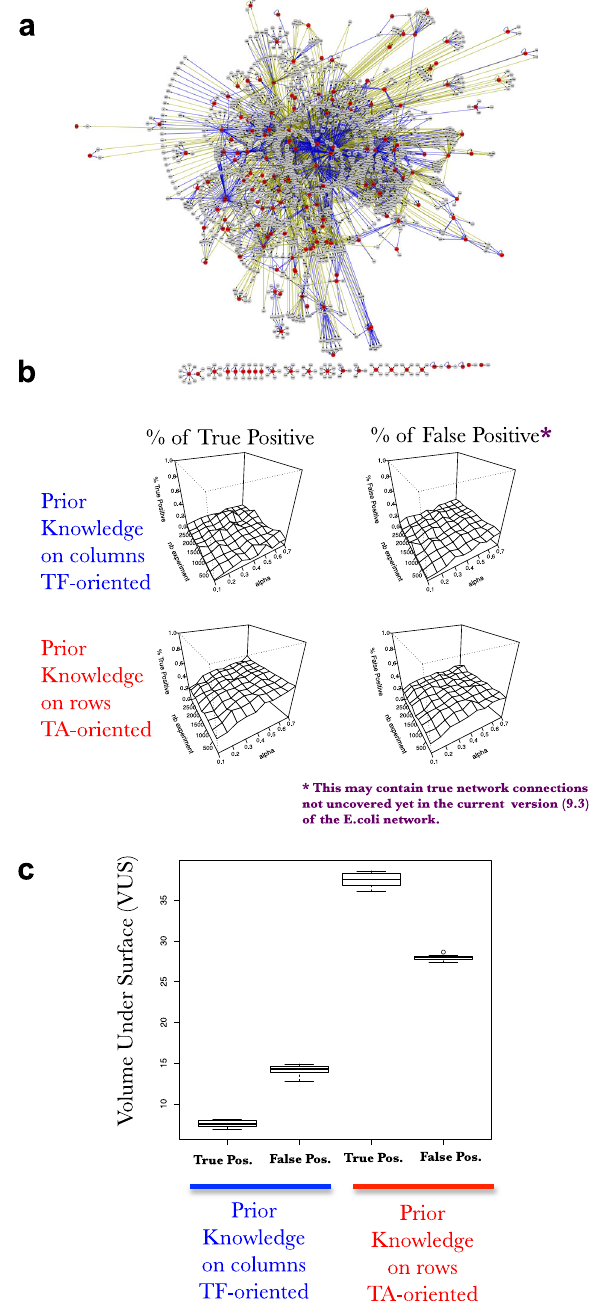
Fig. 5 TA-oriented prior knowledge is superior to TF-oriented prior in order to supervise SVM machine learning on real data. a Cytoscape display of the current E. coli network (version 9.3 retrieved from http://regulondb.ccg.unam.mx/) b Surfaces exploring the SVM accuracy (% of true positive on left and % false positive in right ) to predict the connections in E. coli network (171 TF, 1493 TA) using an increasing number of real gene expressions ( nb experiment ; y -axis) and an increasing fraction of the network as prior knowledge ( alpha ; x -axis). Percentage of true positive and false positive are evaluated based on predictions of the presence of an edge and its positive or negative in fl uence. c Bootstrap results for ten learning processes as the one described in b . For each bootstrap cycle 90% of the network has been resampled and genes expression randomized. The panel represents the boxplot of VUS for the ten learning